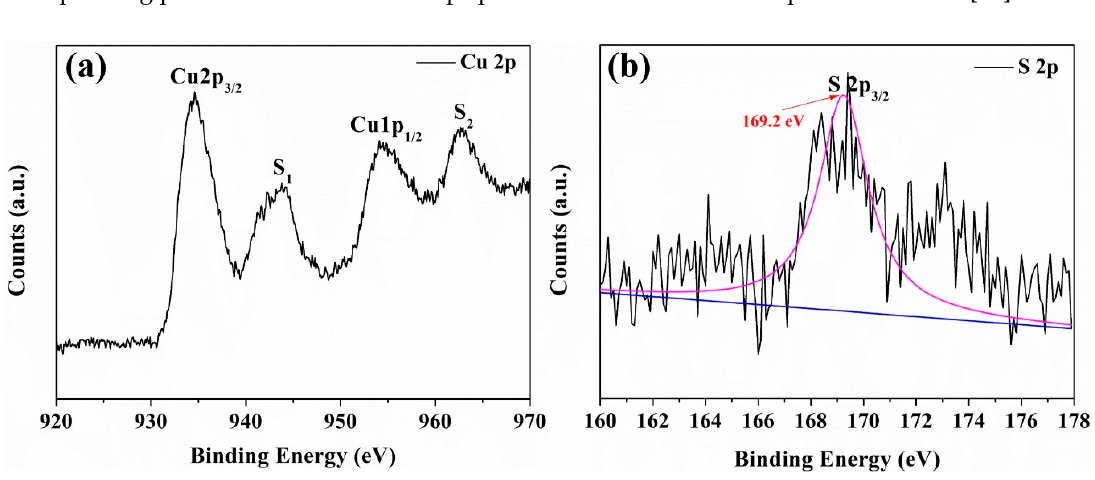
Figure 13. ( a ) Cu 2p and ( b ) S 2p XPS spectra recorded for 1.25 wt % Pt-doped CuO after exposure to 10 ppm H 2 S.